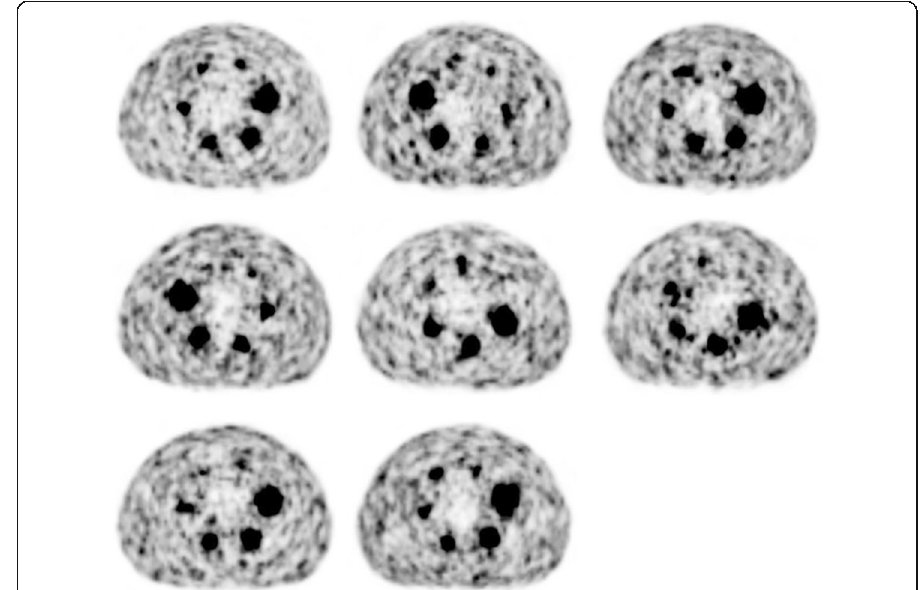
Fig. 2 PET images from first day of imaging (~ 3.0 GBq) for each of the eight